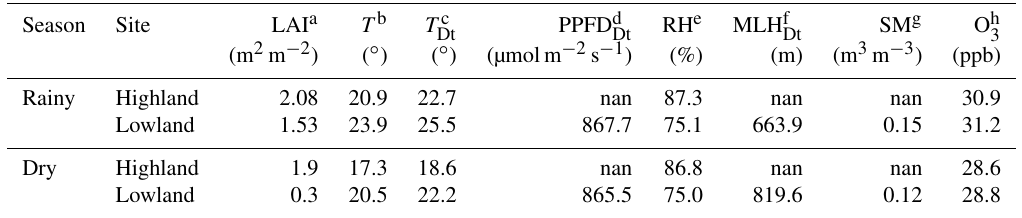
Figure 4. Mixing ratios of isoprene, monoterpenoids, sesquiterpenes, and others (2-Methyl-3-buten-2-ol and bornyl acetate) in the highland and lowland ecosystems during the rainy and dry seasons. Table 1. LAI, the concentration of ozone, and meteorology conditions detected or estimated in the highland and the lowland sites during the campaigns. Parameters which were not measured in situ are